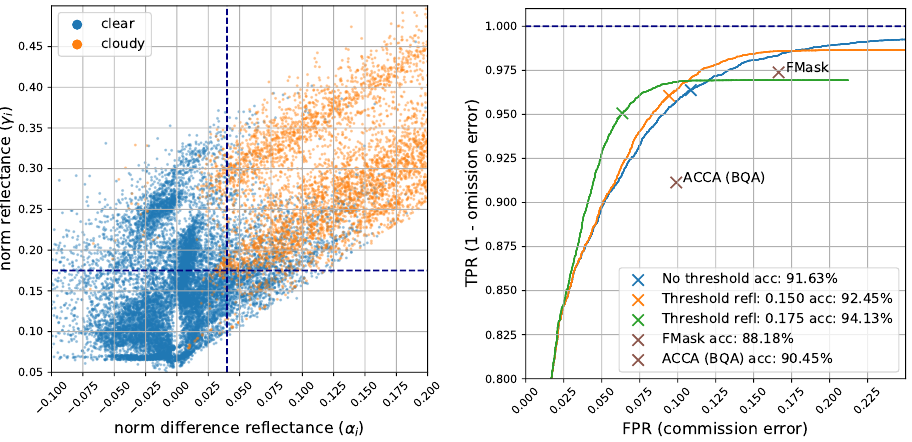
Figure 6. ( Left ) Scatter plot of the clusters. Norm of TOA reflectance of the visible bands on the Y-axis ( γ ) and norm of difference in reflectance on the X-axis ( α ). Each point corresponds to one of the 10 clusters from each of the 2661 image patches. Vertical and horizontal lines show the proposed thresholds. ( Right ) ROC curves with and without the extra threshold on reflectance γ . The median is used for background estimation in both